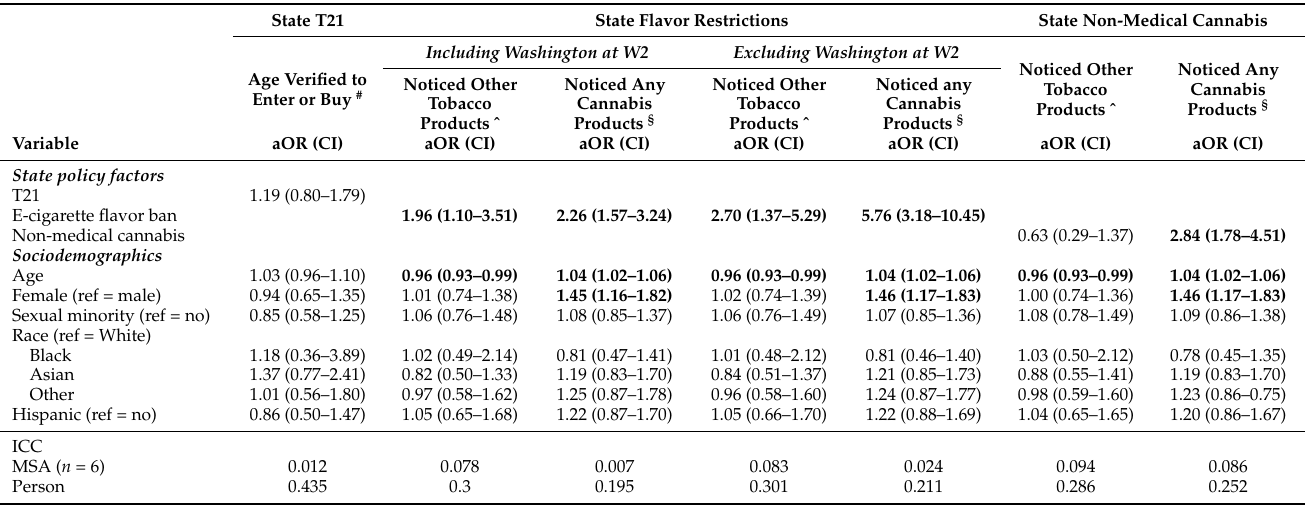
Table 4. Multilevel logistic regression results examining relevant state policies in relation to key vape shop related outcomes among past 6-month e-cigarette users who visited vape shops